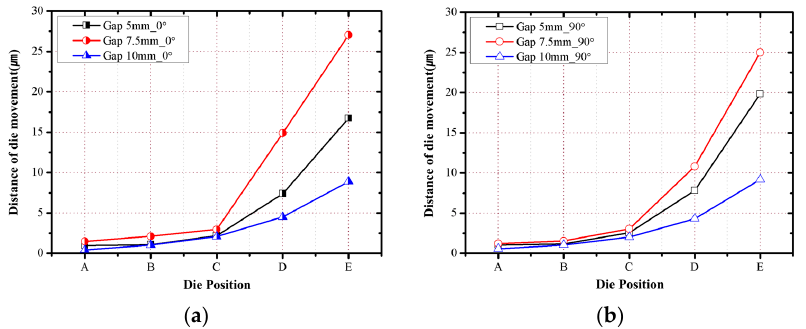
Figure 12. Warpage measurement results: ( a ) 0° direction; ( b ) 90° direction.